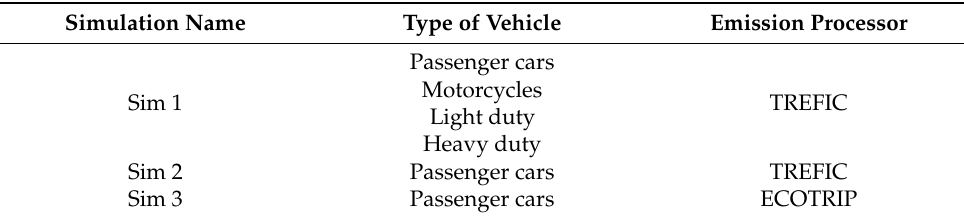
Table 4. Definition of the emission configurations used in the different